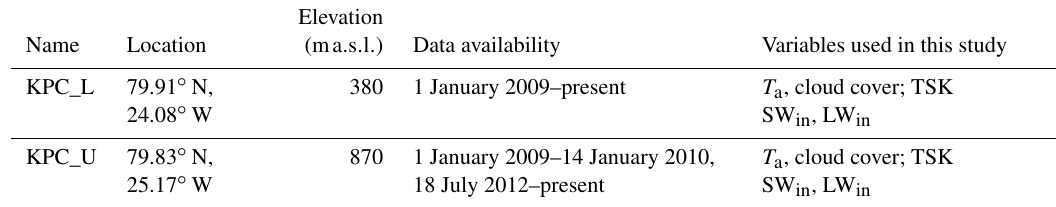
Table 1. Location, elevation, and data availability of KPC_L and KPC_U AWSs. Observations are taken approximately 2m above the surface. T a is air temperature, SW in and LW in are the incoming (downward) shortwave and longwave radiation respectively, and TSK is the skin temperature of the glacier. See van As and Fausto (2011) for more information on observations from the PROMICE